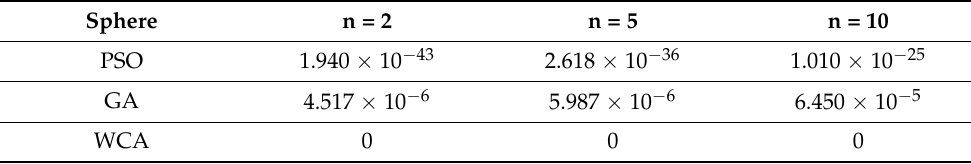
Table 2. The optimal fitness value for Sphere function optimization.